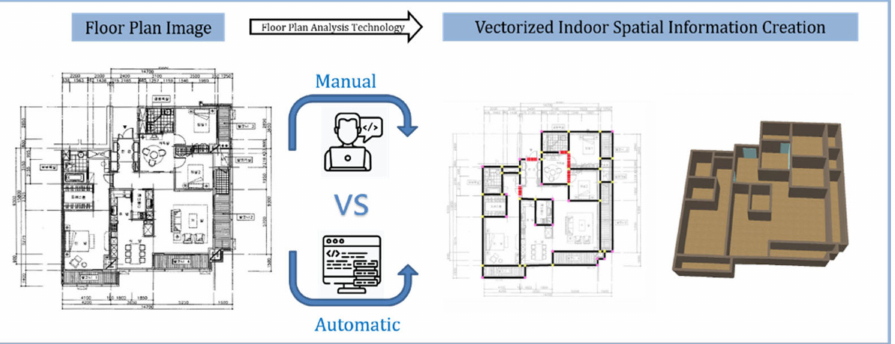
Figure 2. Description of floor plan analysis technology.